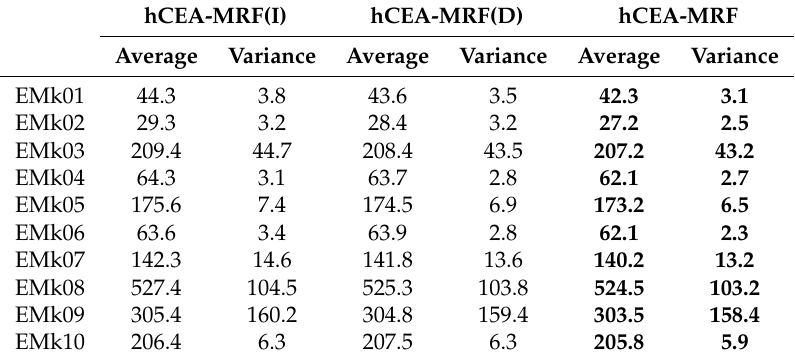
Table 9. The performance of different parameter self-adaptive strategies for the generated instances by exponential